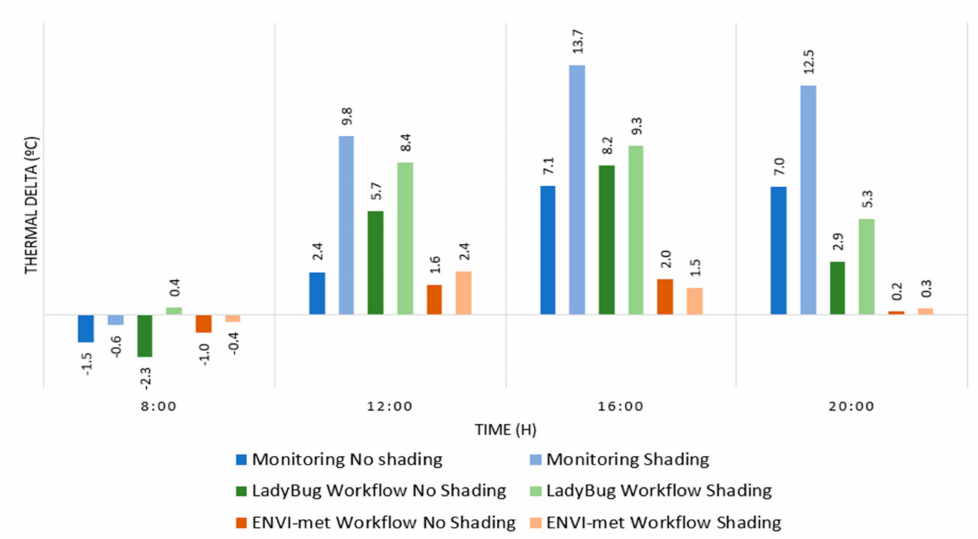
Figure 7. Simulated and monitored thermal delta (TD) at different hours for the different configura- tions